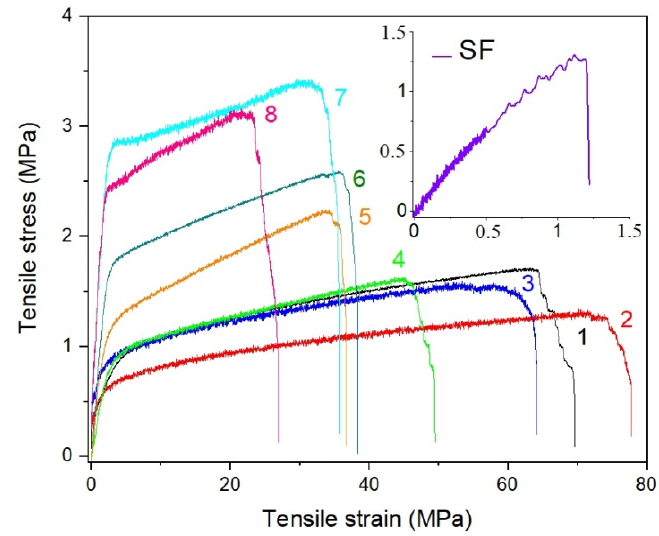
Figure 3. Stress–strain curves for r-PET electrospun mats contained (1) r-PET pure, (2) r-PSF1, (3) r-PSF2, (4) r-PSF3, (5) r-PSF4, (6) r-PSF5, (7) r-PSF6, (8) r-PSF7. The inset shows the stress–strain curve of crude electrospun SF.